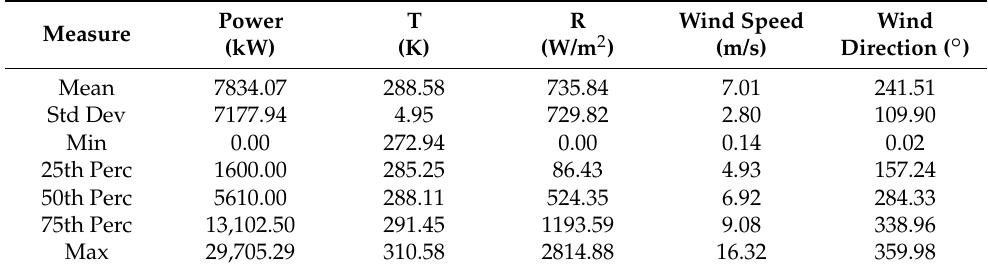
Table 1. Descriptive statistics of wind farm 15.